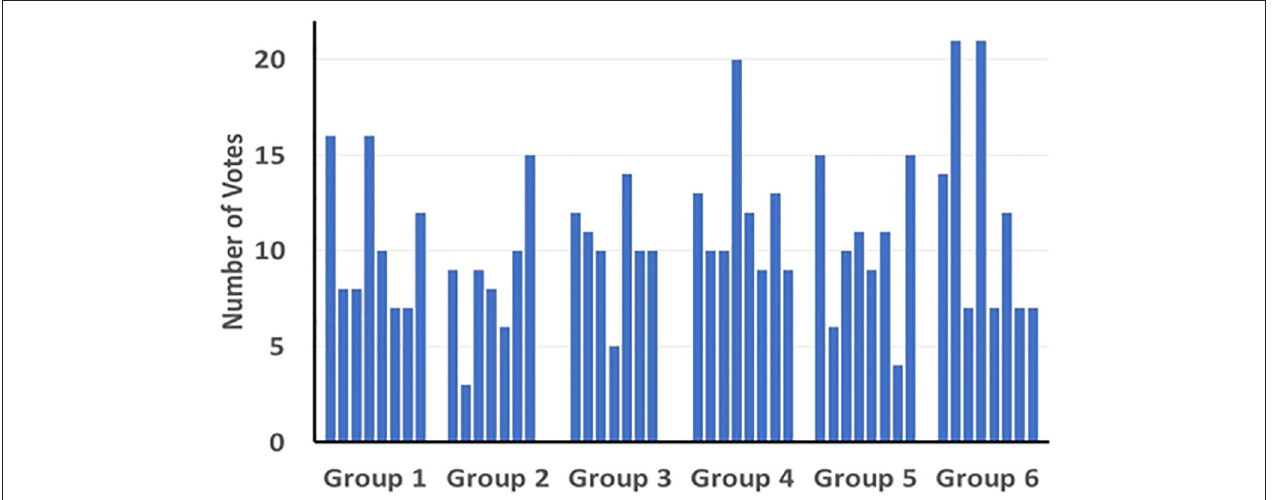
FIGURE 2 | Peer input into assessment: distribution of the total votes for individuals within groups. The total number of votes received by each individual from students within their own group is plotted. Students distributed their votes simply based on their feeling of how much other students contributed to the team effort. Note that the total number of votes cast per group differs because groups had either seven or eight members and not all students voted. Group numbers do not correspond to topic numbers in Table 1 in order to preserve student